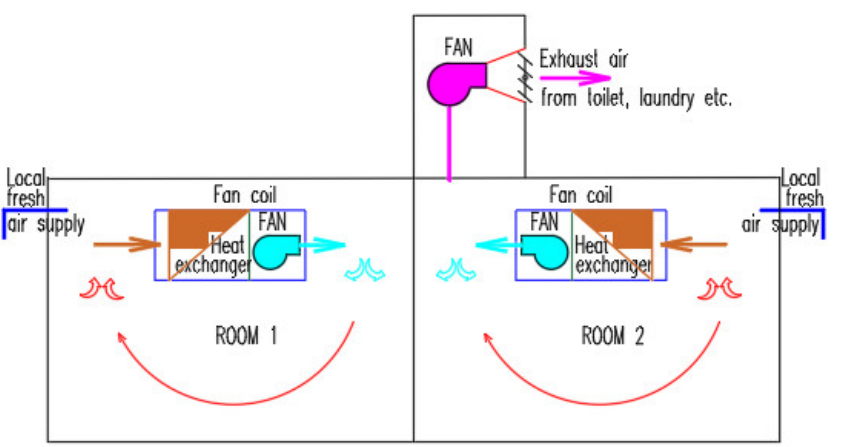
Figure 5. Typical arrangement. Independent ventilation and air conditioning system for small ships and boats, without air recirculation/mixing from/to different rooms.